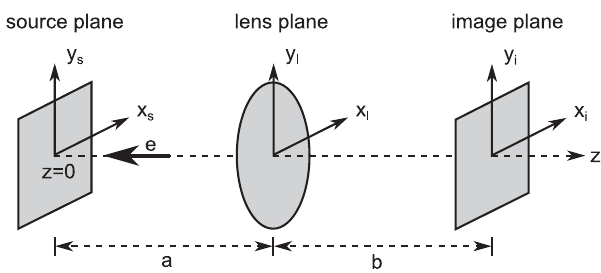
FIG. 1. Sketch of the calculation